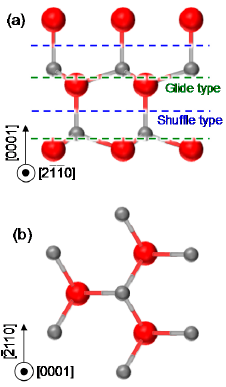
Figure 1. Schematic illustration showing the crystal structure of ZnO with the wurtzite structure. The arrangement of ions along [2110] and [0001] are represented in ( a , b ), respectively. Large red circles correspond to oxygen ions while small gray circles do zinc ions. Locations of slip planes for glide type and shuffle type dislocations are indicated in ( a ) by dotted lines.